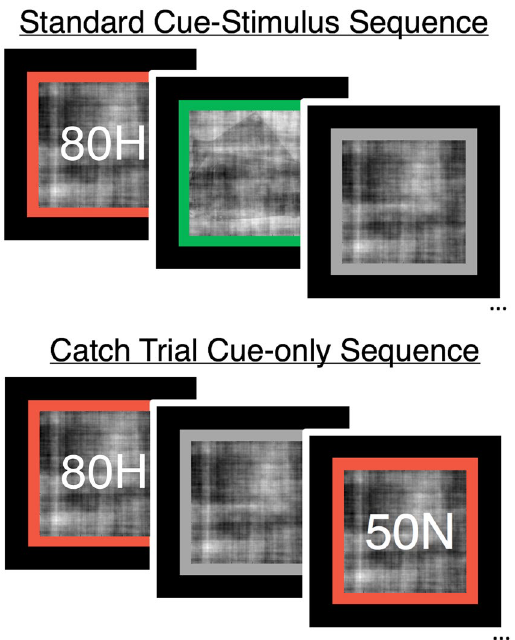
Figure 1. Probabilistic face/house discrimination task. On full trials (top) subjects were shown a cue (letter number combination over noise-only movie; red border) informing them of the prior probability of each stimulus category, followed by a noise-degraded movie of either a face or house stimulus (green border), and finally a jittered rest period (noise-only movie; gray border). On catch trials (bottom), subjects were shown a cue followed immediately by a rest period and were instructed to wait for the next